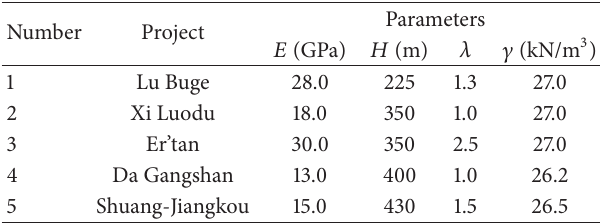
Figure 1: The sketch of core area and peripheral area (bold line for core area).